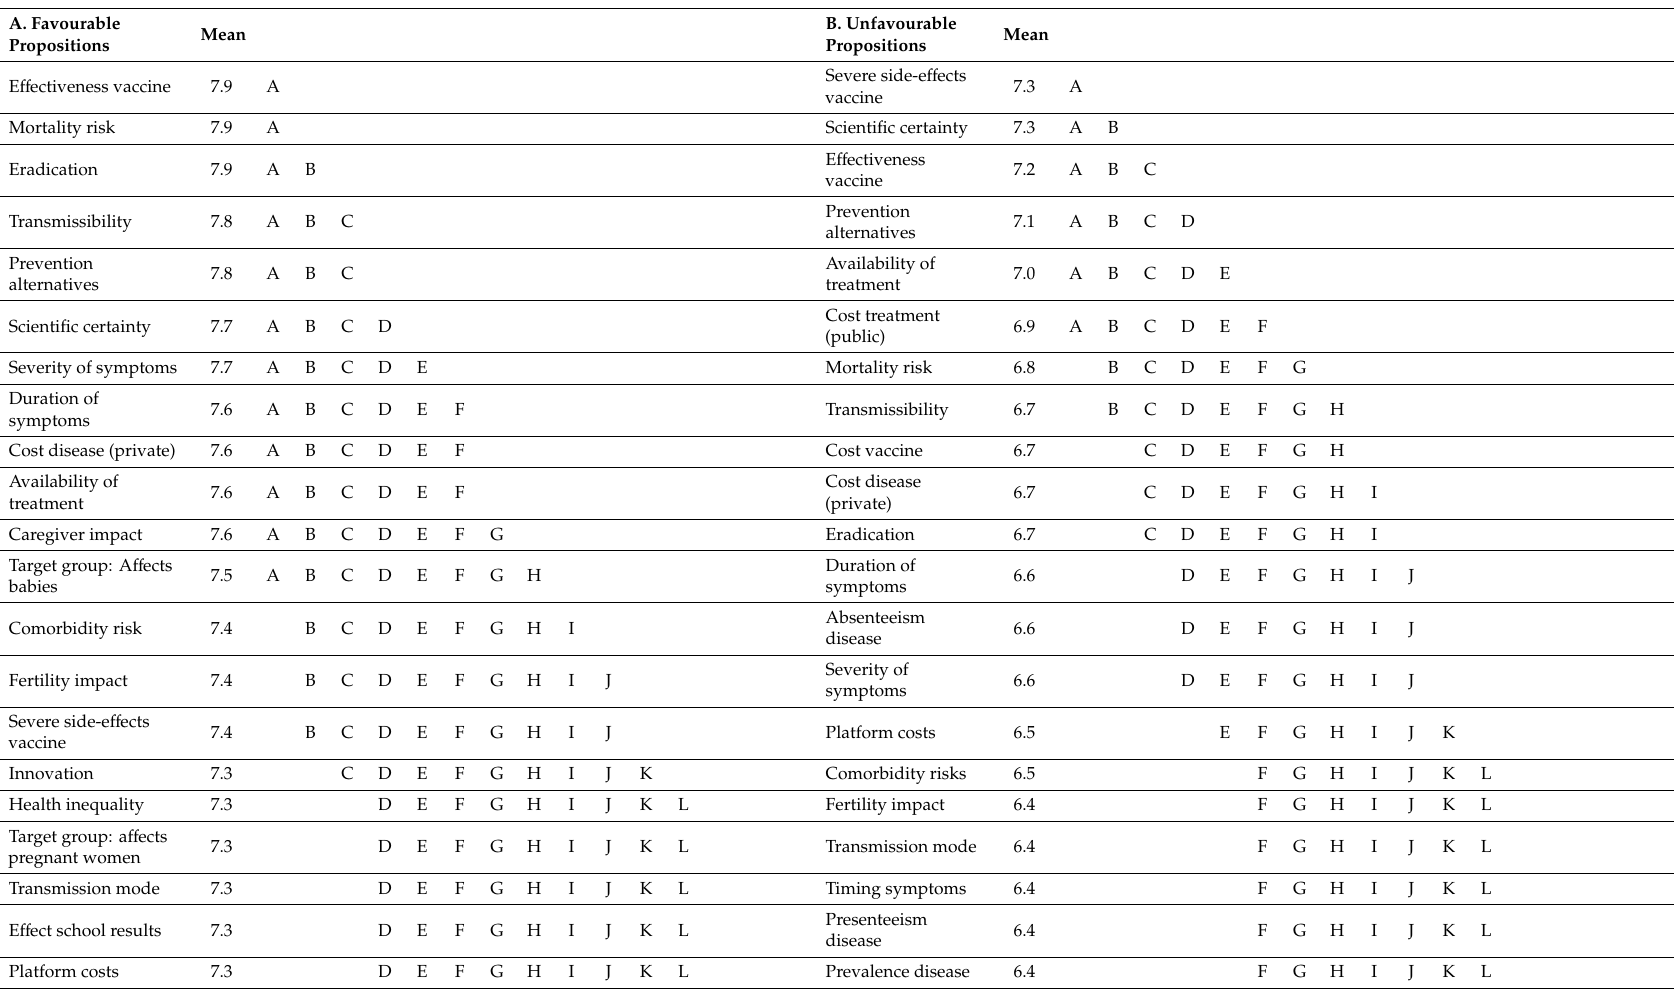
Table 3. Analysis of variance (ANOVA) for analysing di ff erences in the mean scores for the 40